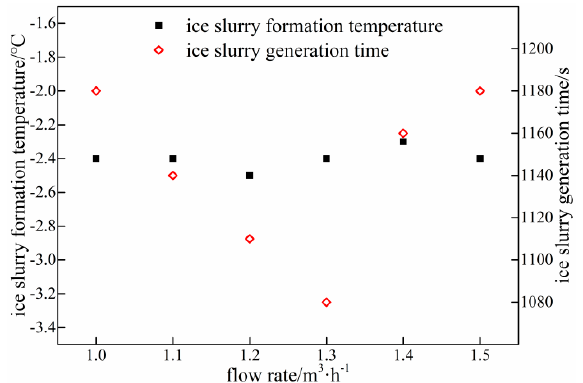
Figure 9. Ice slurry formation characteristics at different flow rates.